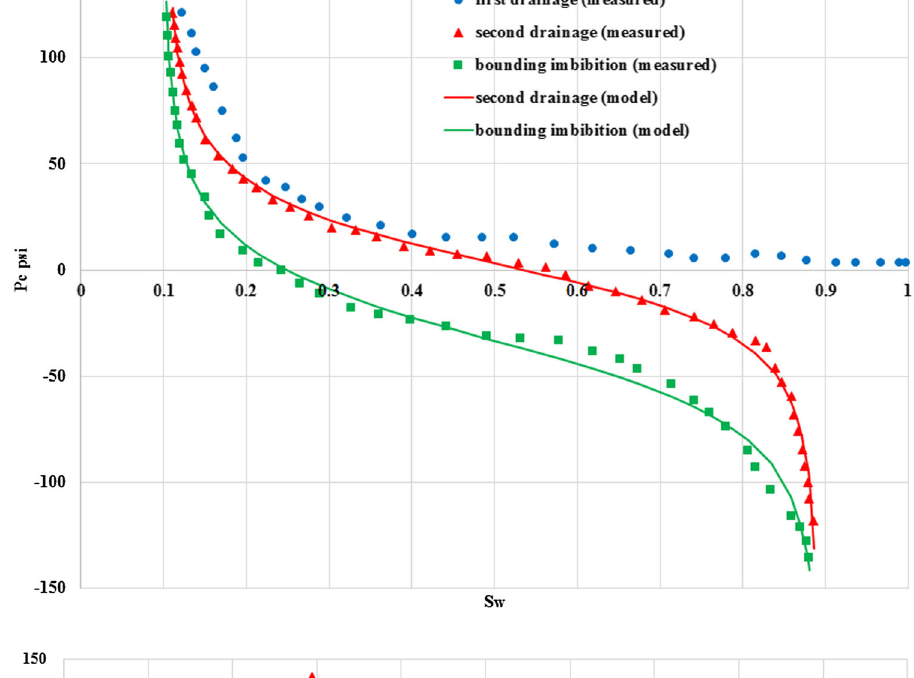
Fig. 6 Curve fitting of bounding imbibition and secondary drainage P c for